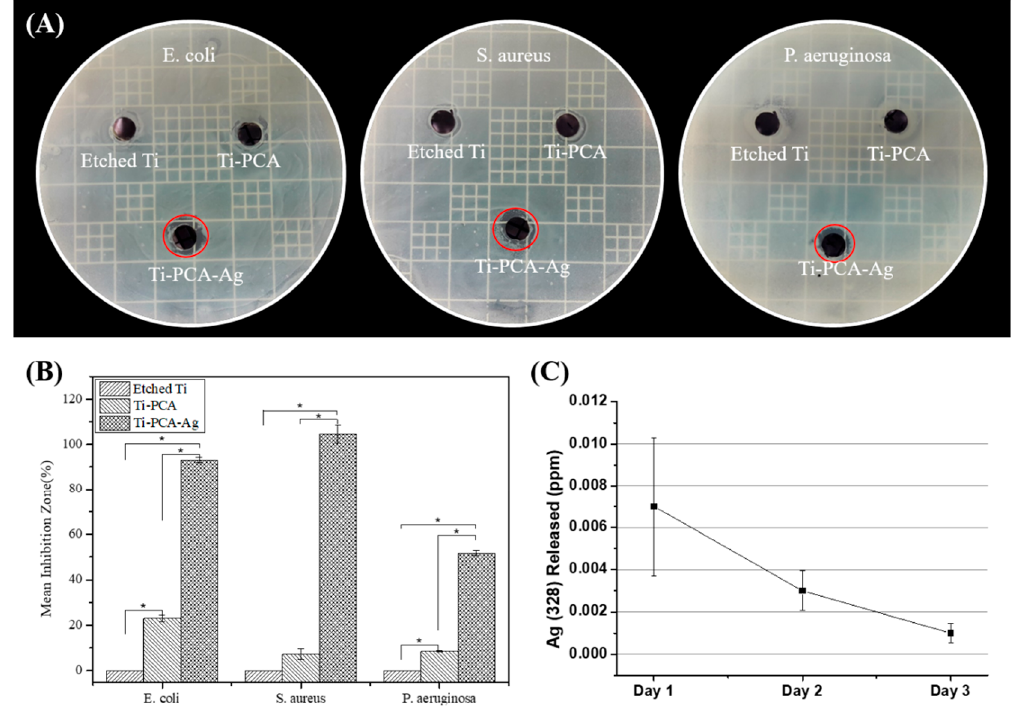
Figure 5. Representative images of antibacterial activities using ( A ) E. coli ( left ), S. aureus ( middle ), and P. aeruginosa ( right ) after 24 h after adhered specimens. ( B ) Graph of inhibition zone measured by Image J software ( n = 3 and * indicates statistical significance ( p < 0.05) measured by one way ANOVA Tukey test). ( C ) Ag 328 elution from the Ti–PCA–Ag detected via inductively coupled plasma atomic emission spectroscopy (ICP-OES) ( n = 3).